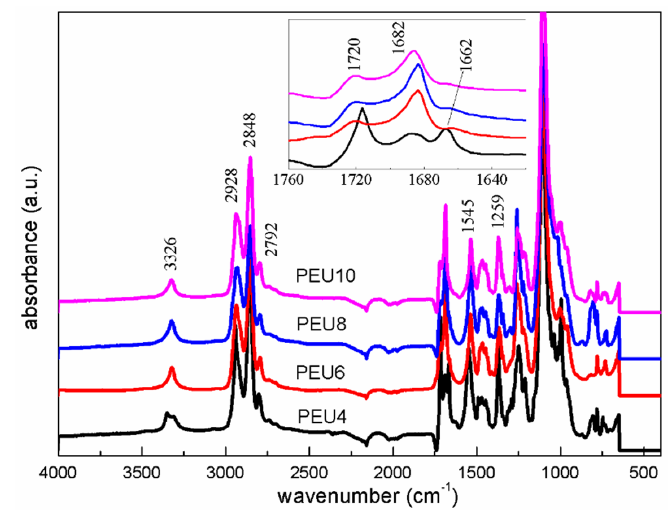
Figure 4. ATR–FTIR spectra of Figure 4. ATR−FTIR spectra of PEU.